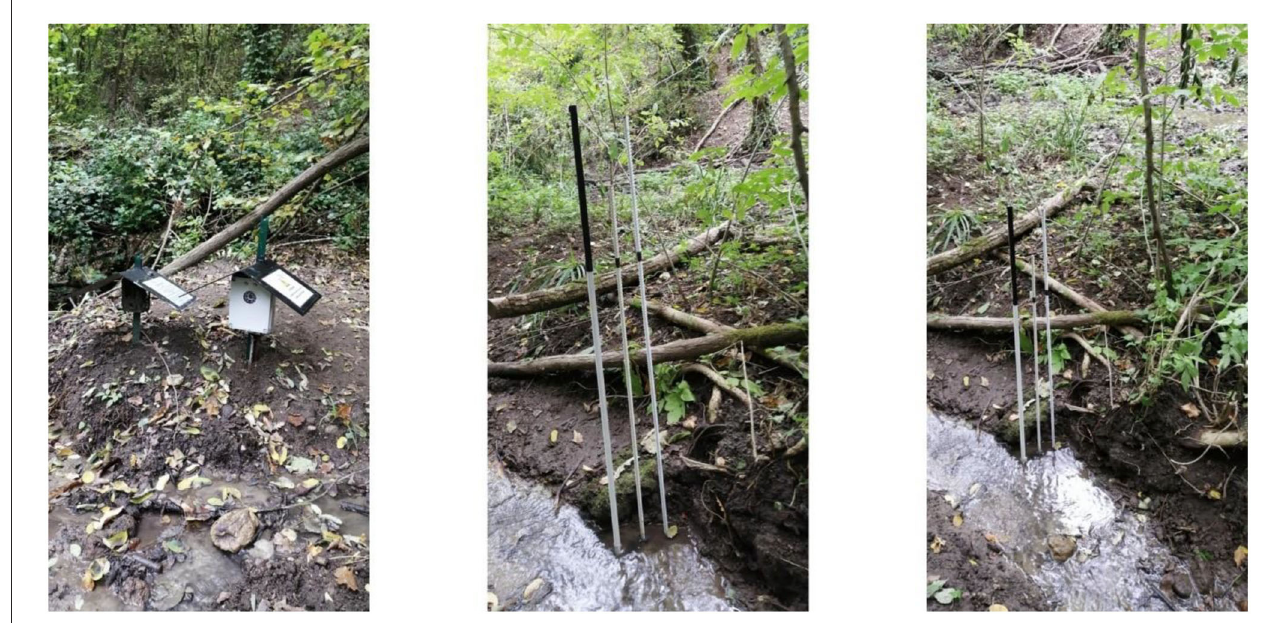
FIGURE1 An example of stage-cam system installed at the Montecalvello basin.